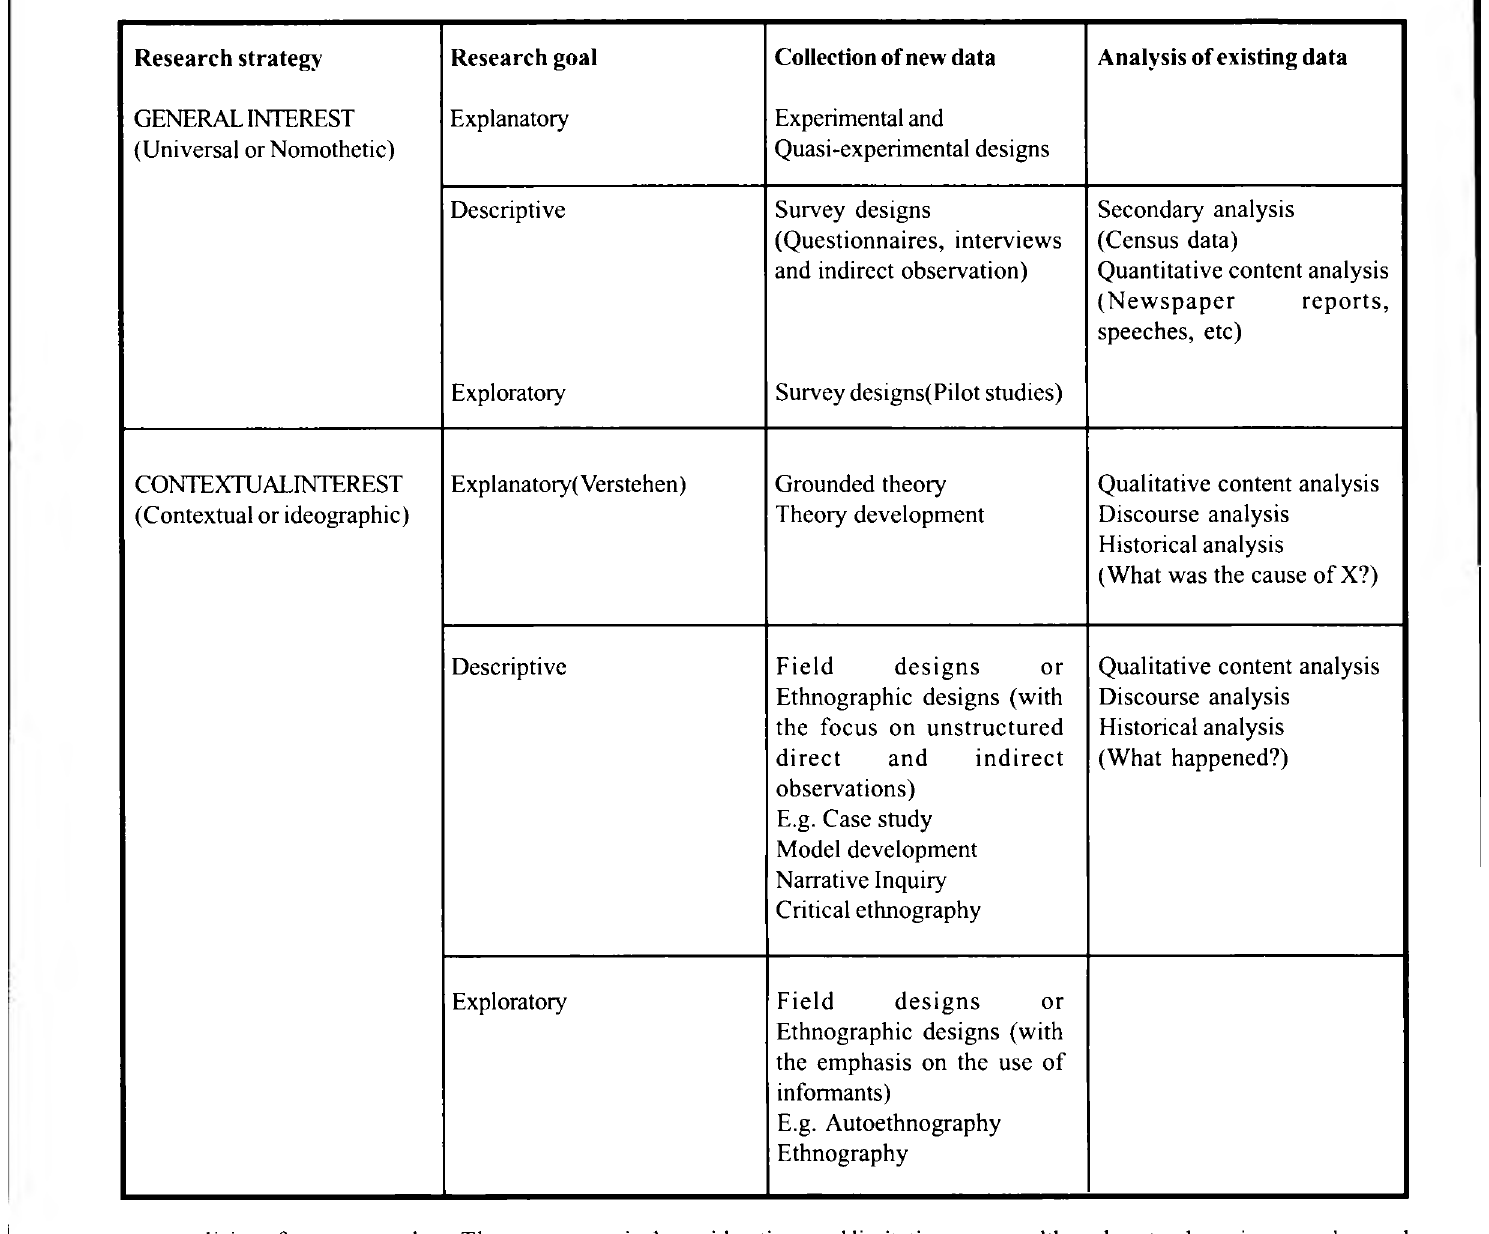
Table 2. Typology of research designs (adapted from Mouton and Marais 1996) Research